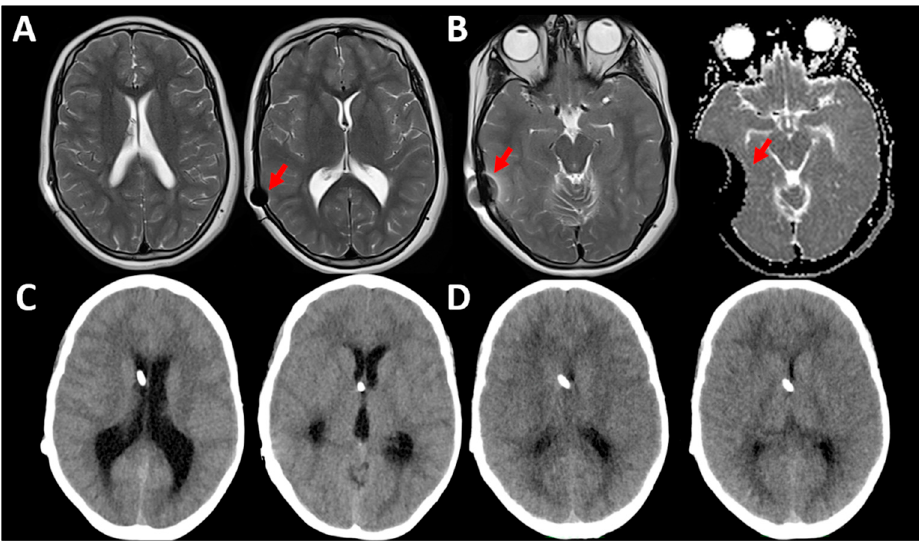
Figure 8. This 13-year-old girl had surgery for a Chiari 1 malformation with hydrocephalus. She had a Hakim programmable valve implanted with an OP of 70 mmH 2 O. The patient was scanned in a 1.5 T MRI for control ( A , B ). In ( A ), the ventricular size was normal. Arrows show the magnetic artifact produced in the different MR1 sequences that was moderate in T2-weighted images and very strong in the diffusion-weighted sequences ( B ). The patient’s valve was accidentally reprogrammed by the doctor on call to an OP of 150 mmH 2 O immediately after the MRI. She was admitted three days later because of headache and drowsiness. The CT scan on admission ( C ) showed a significant increase in the ventricular size. The OP of the valve was readjusted to 70 mmH 2 O. The patient improved and the new CT scan at discharge is shown in ( D ).